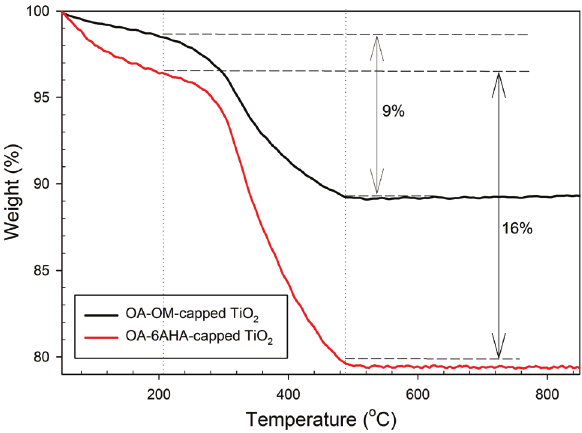
nanoparticles (A1) and 2